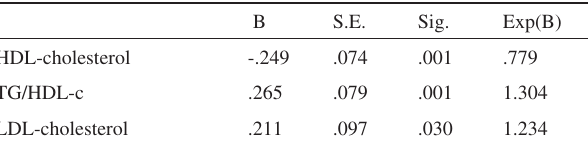
Table 3 - Results of multivariate